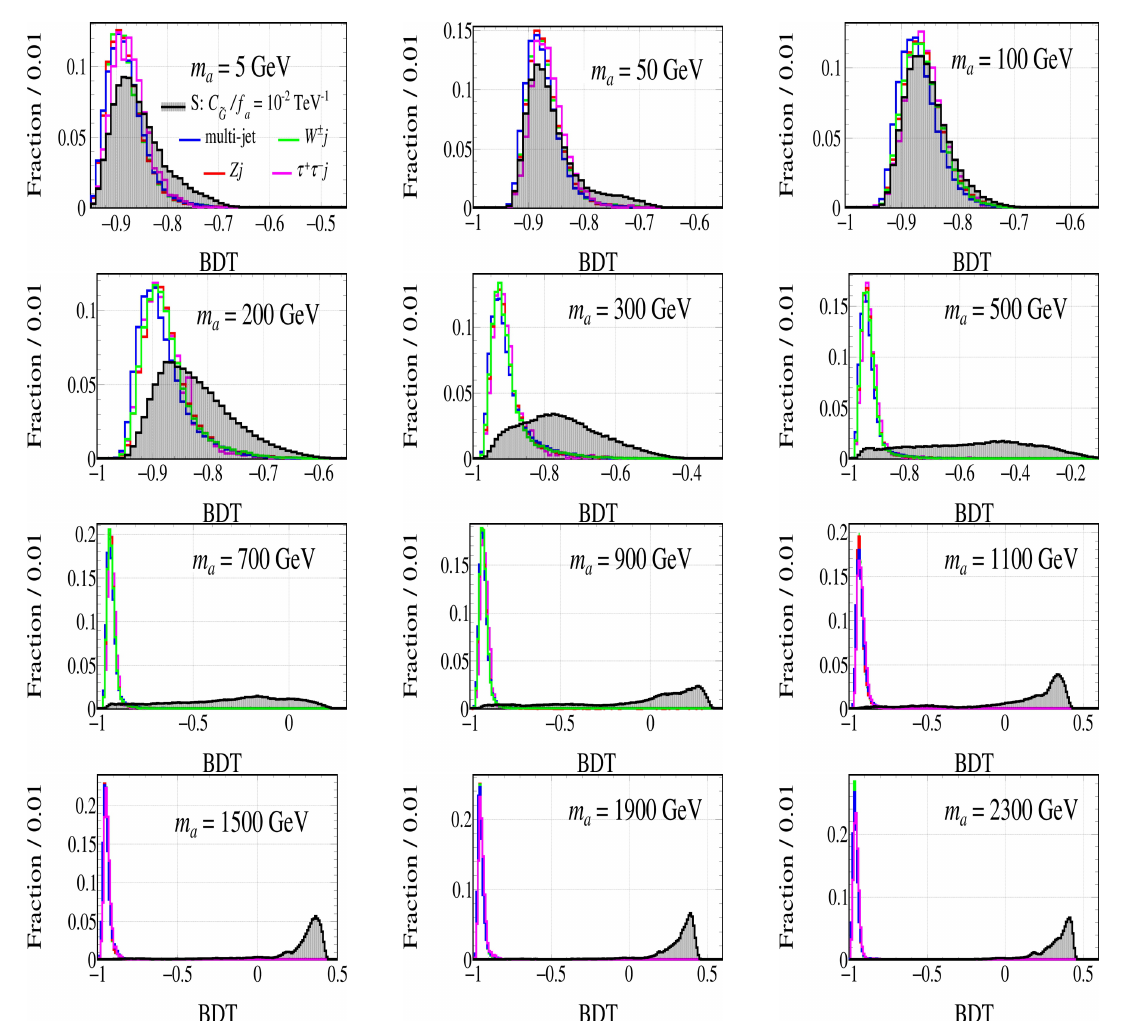
Figure 9 . BDT response distributions for the signal (black, filled) with fixed parameter C ˜ 10 − 2 TeV − 1 and dominant SM background processes at the HL-LHC assuming different m a